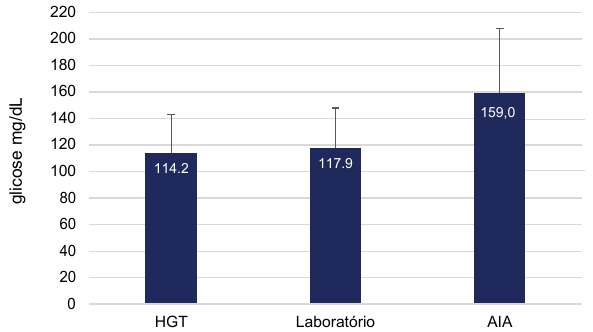
FIGURE 2 - Graphical analysis of the linear correlation by rank between glucose measurements by glucometer (HGT) and conventional laboratory measurements